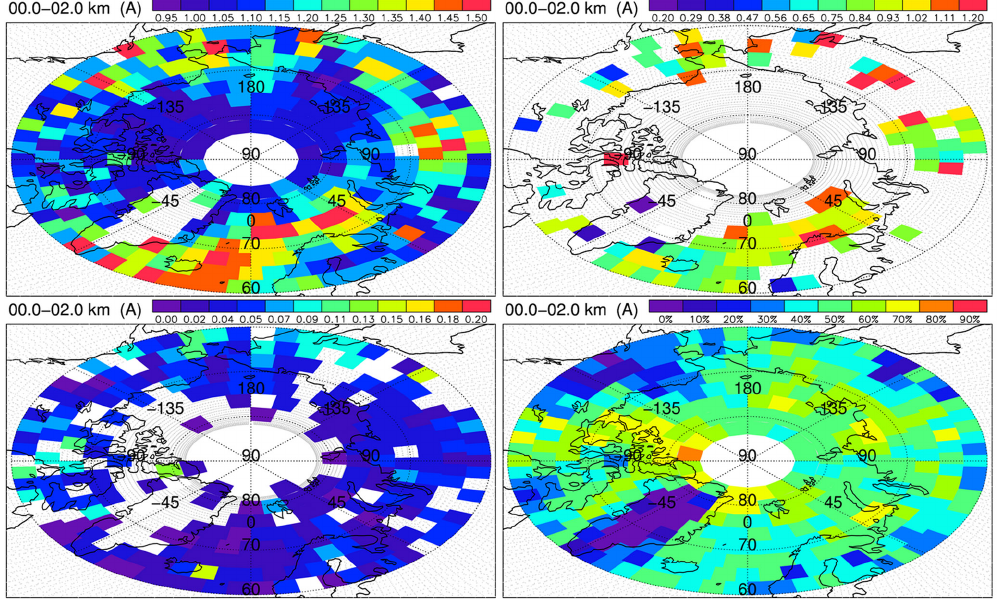
Figure 13. Map of the 532nm backscatter ratio (top left), aerosol colour ratio (top right), pseudo-depolarization ratio (bottom left) and fraction of cloudless observations (bottom right) using the April 2008 filtered level 1 CALIOP data in the 0–2km altitude range. Colour scales are in relative